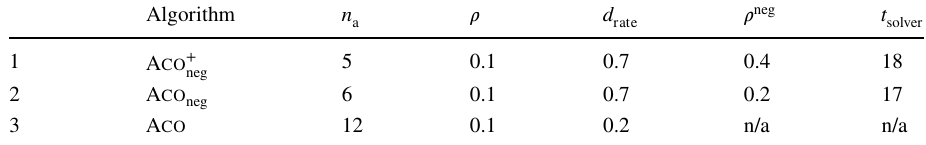
Table 9 Parameter values obtained for all A CO algorithms concerning the Villagra and Barán [36] instances